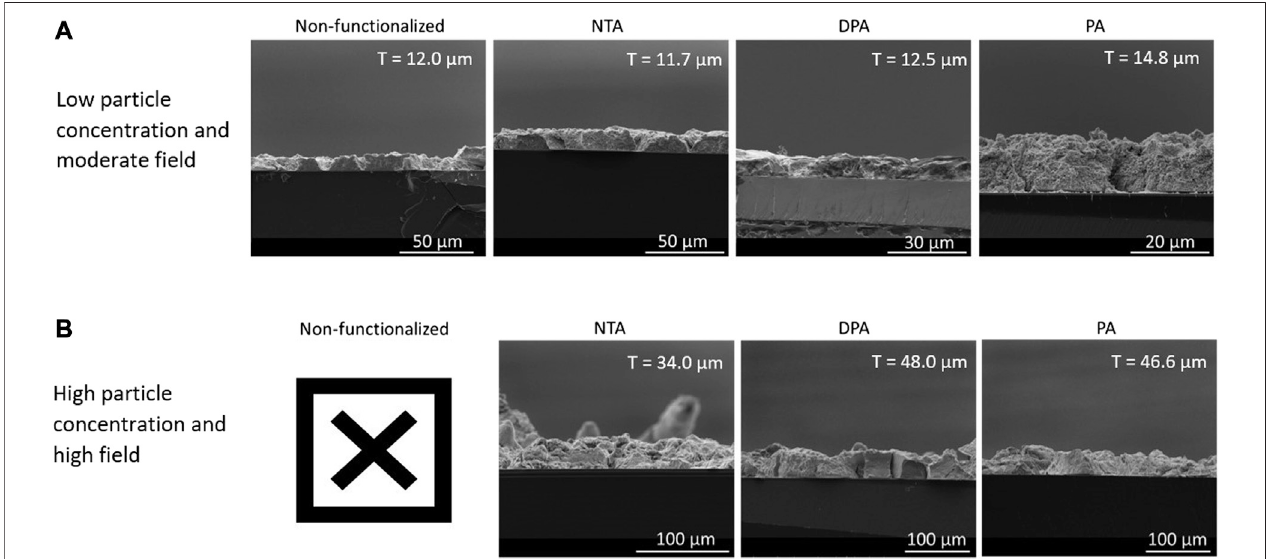
FIGURE5| Panel ofcross-sectionalSEM micrographs showing the fi lmsfor substrates thatare non-functionalized and thosefunctionalized withNTA, DPA,or PA for the (A) low particle concentration and moderate fi eld and (B) high particle concentration and high fi eld conditions. The “ X ” in panel (B) indicates that cross-sectional SEM images were not able to be obtained for the non-functionalized samples. The average thickness of each fi lm is indicated by “ T ” in the top-right corner of each SEM